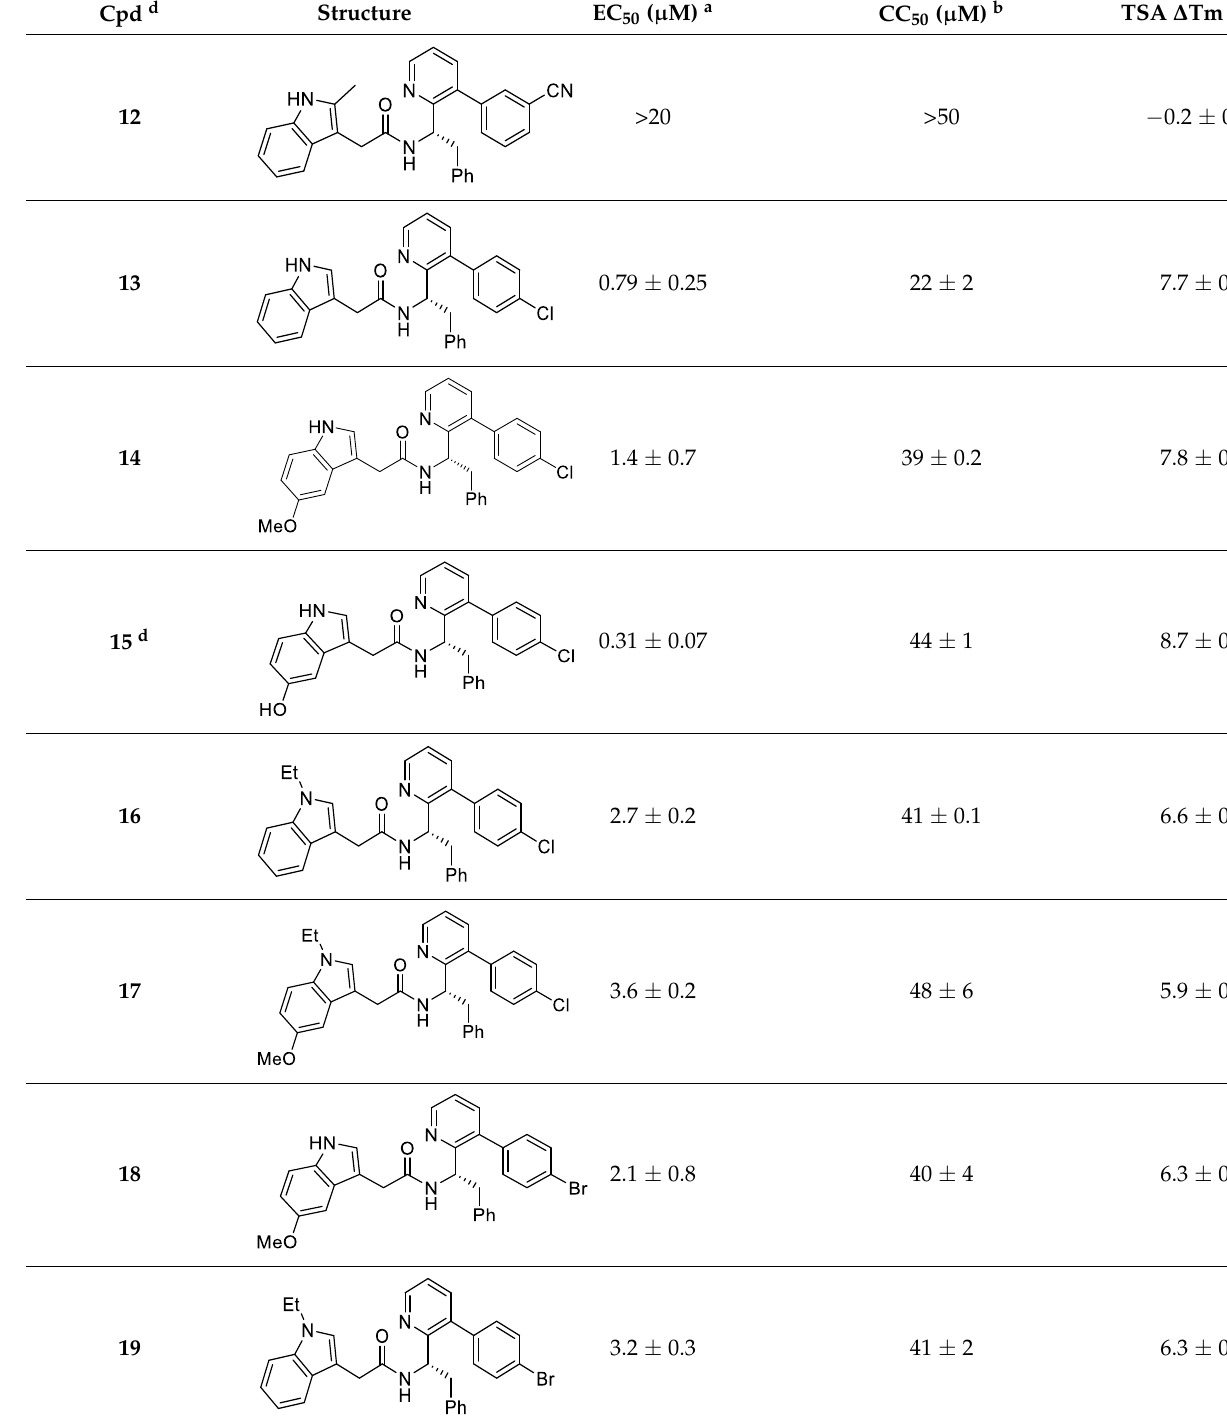
a Concentration of compound inhibiting HIV-1 replication by 50%, expressed as the mean ± standard deviation from at least two independent experiments. b Concentration of compound causing 50% cell death, expressed as the mean ± standard deviation from at least two independent experiments. c TSA: thermal shift assay. ∆ Tm: change of CA crosslinked hexamer melting temperature in the presence of compound minus melting temperature of CA crosslinked hexamer in the presence of DMSO (control). d SI (selectivity index = CC 50 /EC 50 ): 109 (PF74), 142 ( 15 ).